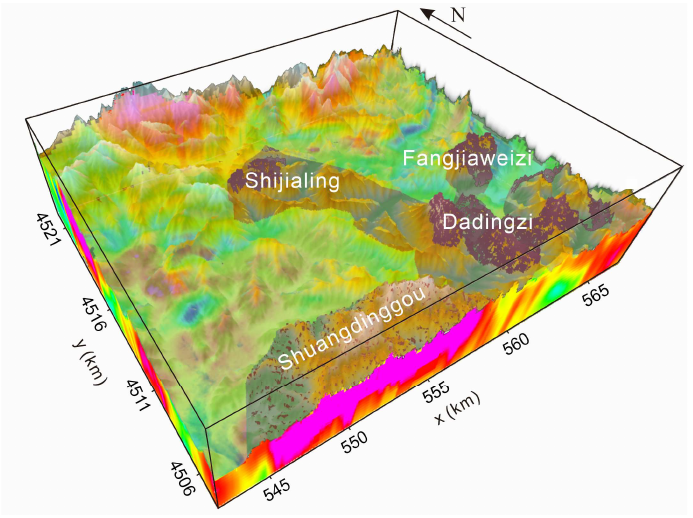
Figure 12. A basic understanding of the of underground rock masses inferred from the resistivity model. ity